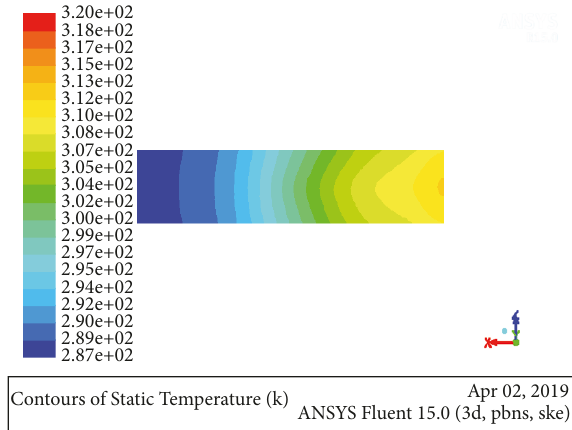
Figure 8: The velocity distribution of support in Test B1.